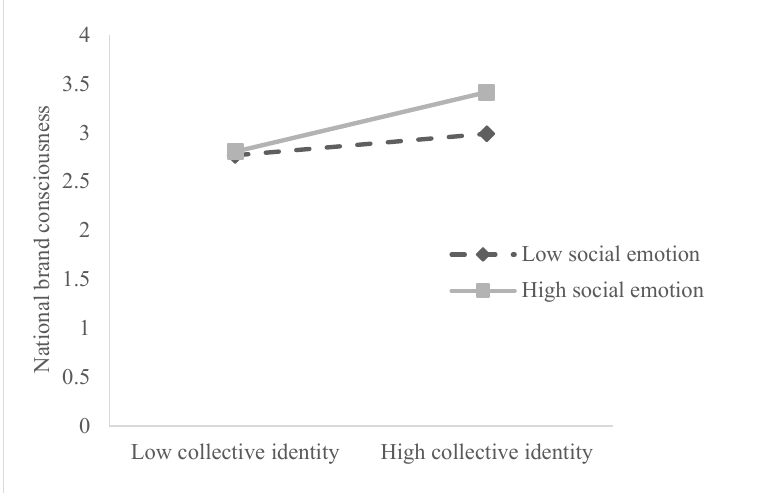
Figure 4. Moderating effect of social emotion on collective identity and national brand conscious- ness.